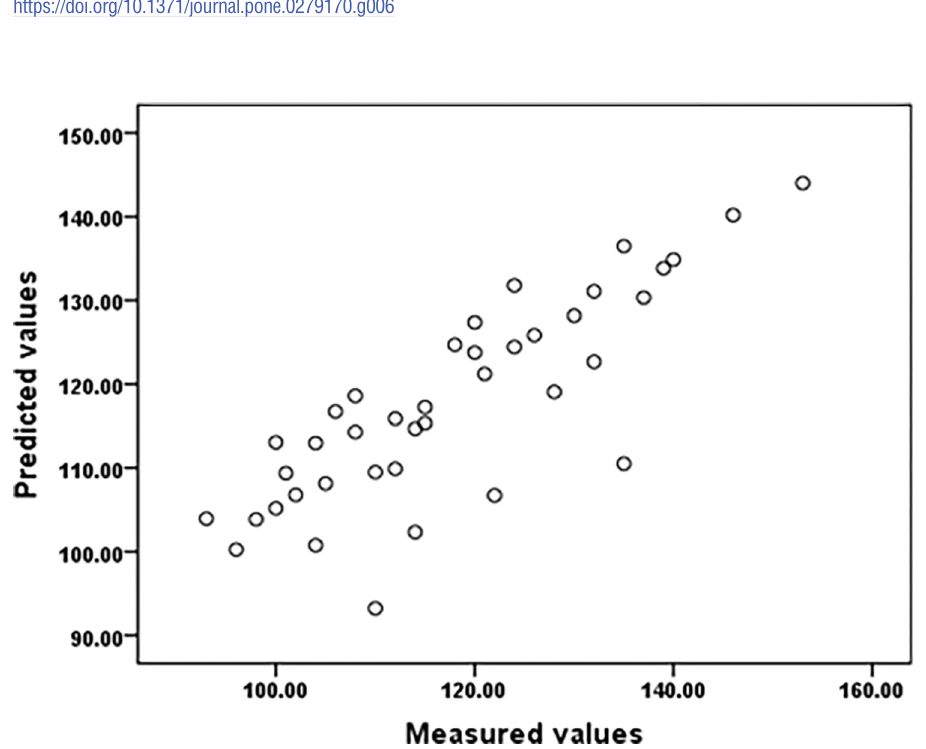
Fig 7. The heart rate (HR) measured values compared to the predicted values based on LMM.